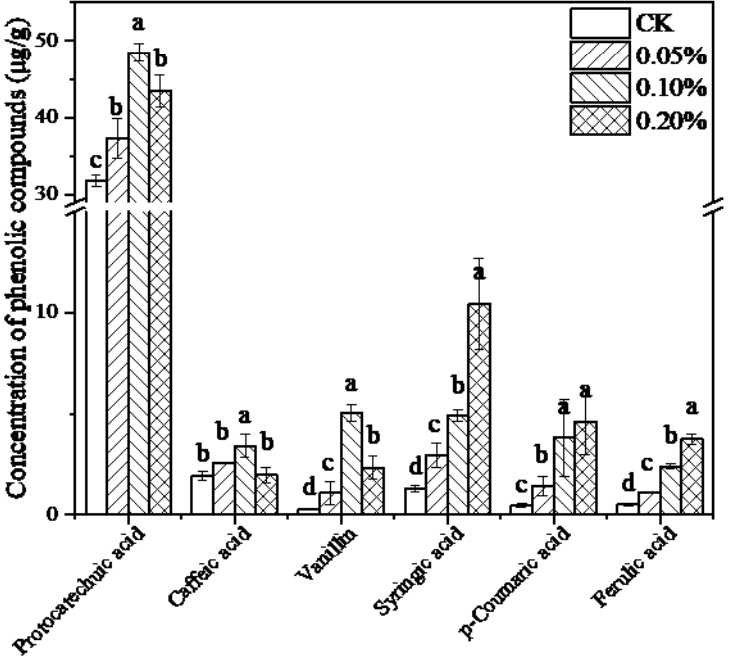
Figure 2. Contents of phenolic compounds from L. edodes mycelium cultured in lignin-containing medium. Results are presented as mean ± SD, n = 3. Different letters represented the significant differences among sample groups ( p < 0.05). Statistical analysis was carried out by one-way ANOVA accompanied by Duncan’s test using SPSS (version 20.0).